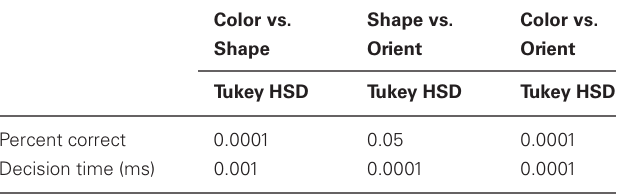
Table 2 | Systematic changes in cognitive decision-making performance occurring in parallel with motor (speed) learning: condition’s pair wise